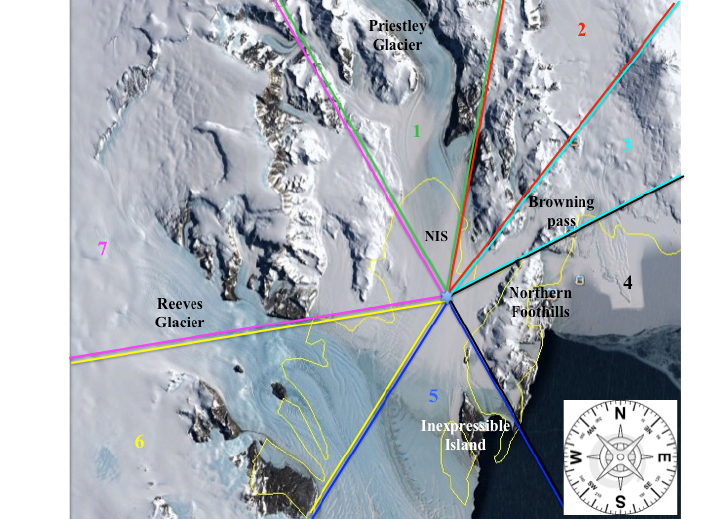
Figure 1. Satellite image of Victoria Land in West Antarctica. The star indicates the position of the micrometeorological tower located in the middle of a flat snowy homogeneous area on the Nansen Ice Sheet (NIS). The coloured lines bound the wind direction sectors used to classify the analysed data as defined in Section